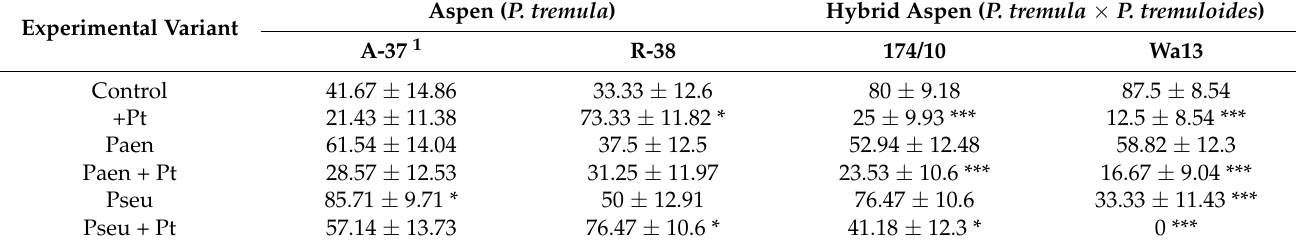
Table 2. Percentage of rooted explants in the in vitro cultures of four Populus genotypes after second stage of culturing with different microorganisms. In the first stage, the nutrient medium was inoculated with either Paenibacillus sp. (‘Paen’) or Pseudomonas sp. (‘Pseu’) bacteria. For the second stage, explants from each variant were transferred onto fresh medium, either sterile or inoculated with fungus P. tremulae (‘+ Pt’). The control group of explants was cultured on sterile media during both stages.